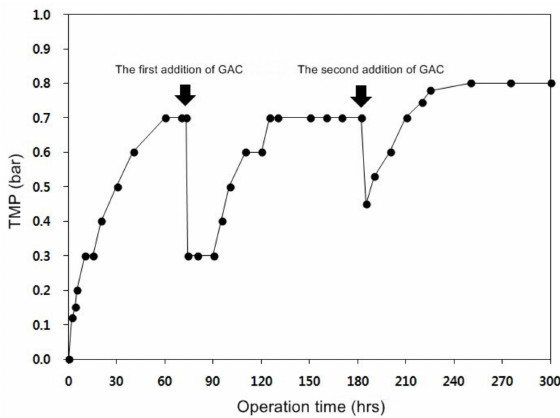
Figure 3. Transmembrane pressure (TMP) profiles of an intermittently aerated single membrane reactor with the addition of 0.5% (V/V) GAC.